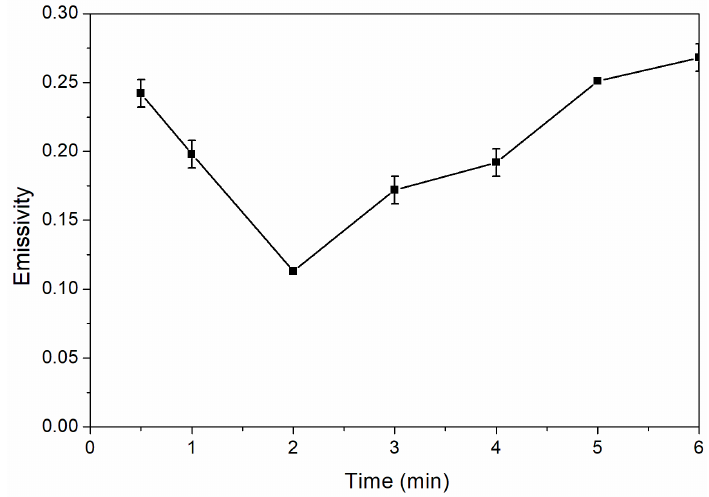
ff ect of drying time on infrared emissivity of the Figure 4. Effect of drying time on infrared emissivity of the coating. Figure 4. E Figure 4. Effect of drying time on infrared emissivity of the coating.